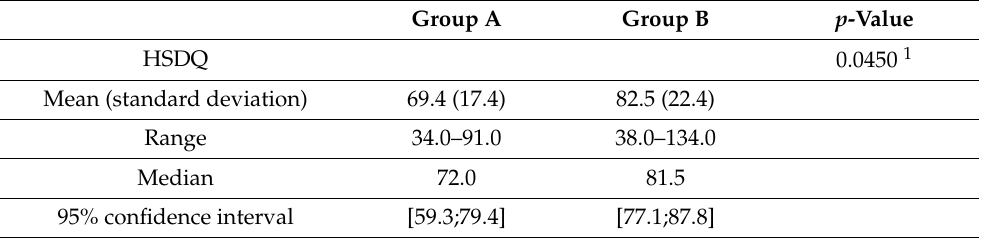
Table 3. Comparative characteristic of depressed patients with mild or no urological symptoms (Group A, n = 70) and depressed patients with moderate or severe urological symptoms (Group B, n = 32) in terms of the sleep quality based on